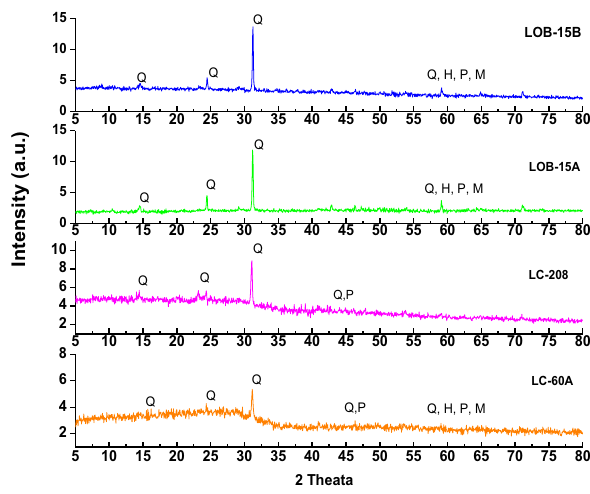
Fig. 34 XRD graph for raw coal and OB of Ledo colliery